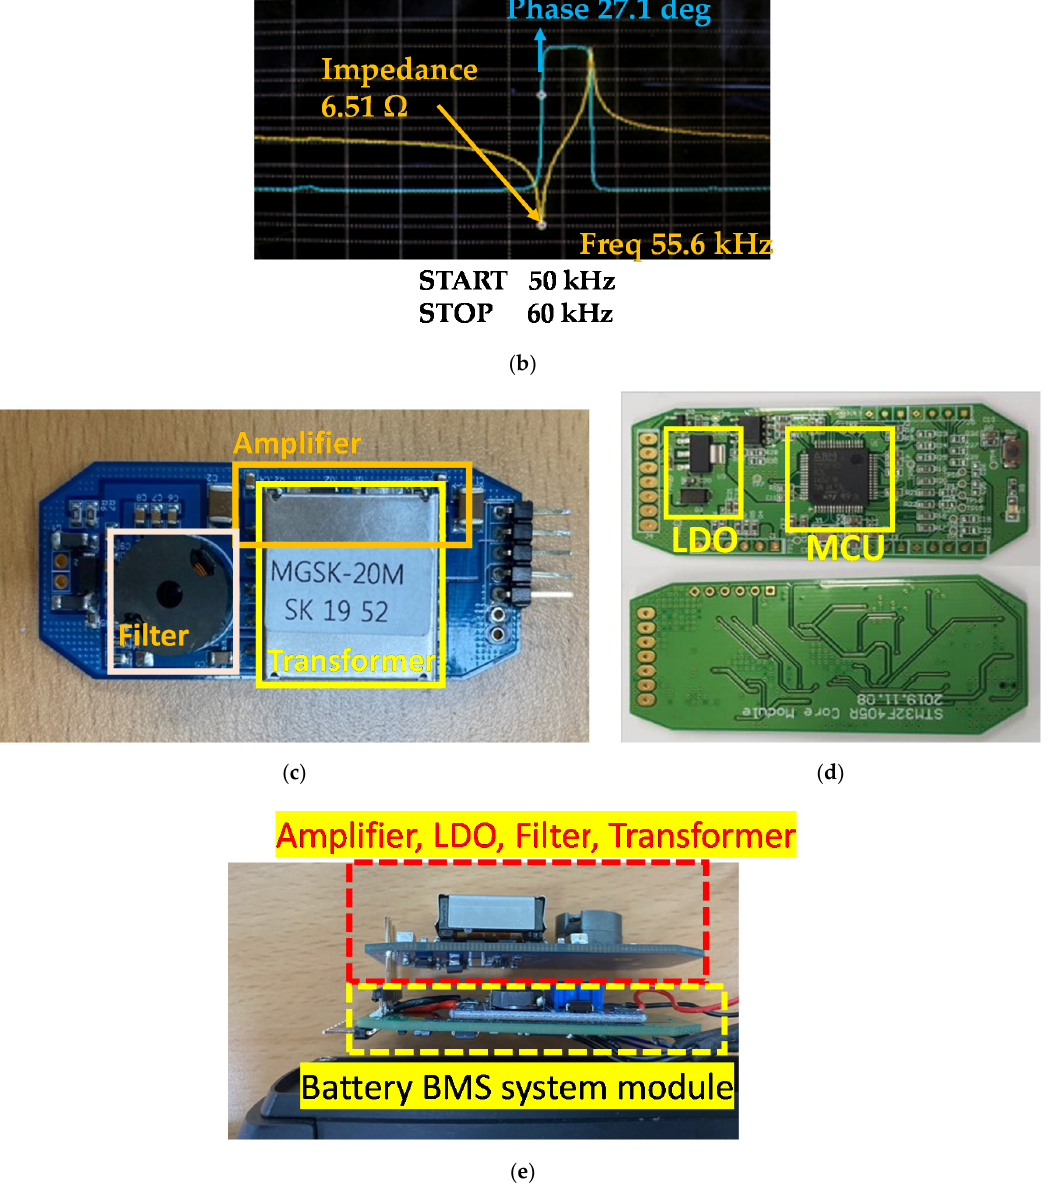
Figure 6. Measured impedance graphs ( a ) before the re-poling process and ( b ) after the re-poling process. ( c ) Frequency detector, transformer, level shifter, LDO, and amplifier, ( d ) MCU modules on the PCB, and ( e ) assembled components on the PCB.